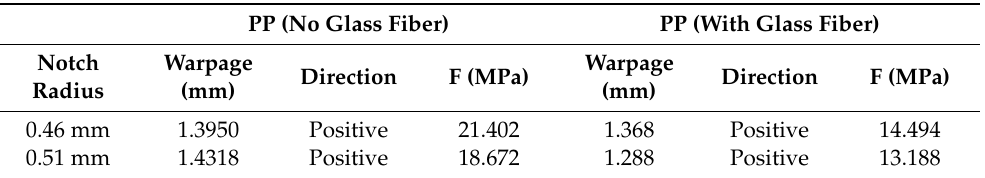
Table 9. Comparison of theoretical warpage and stress between PP materials (no glass fiber) and PP materials (with glass